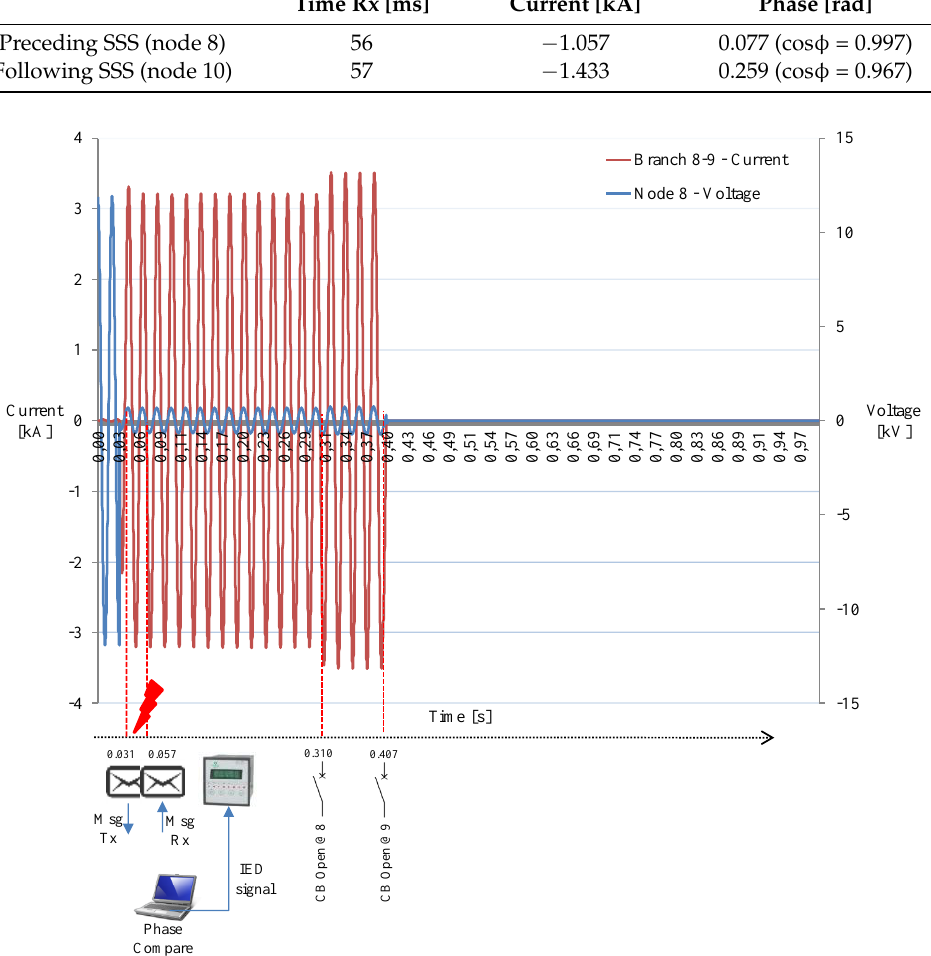
Figure 10. Voltage profile at node 8, and current profile in branch 8–9.